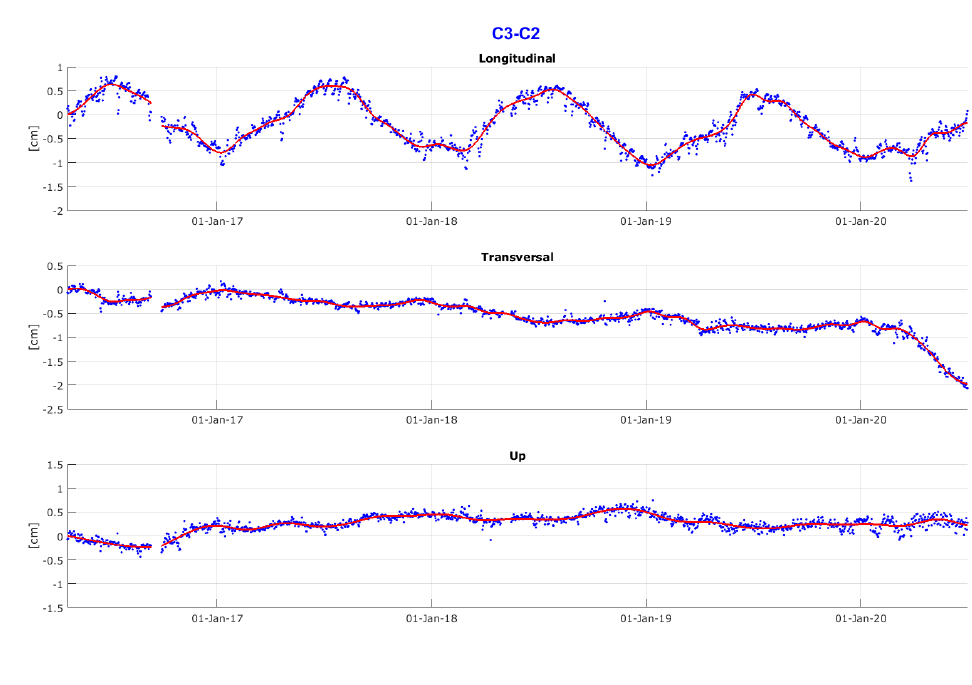
Figure 6. Daily solutions of C3–C2